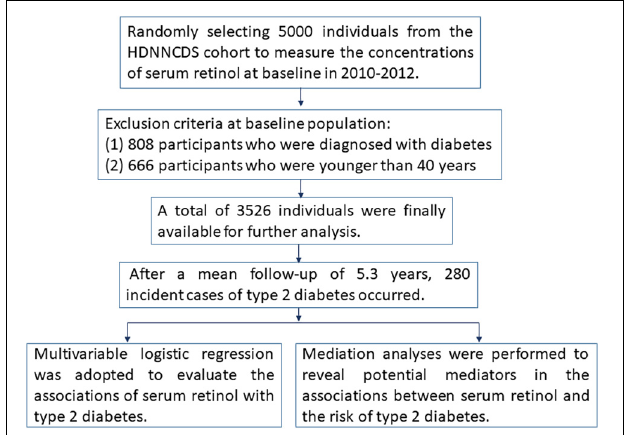
TABLE 1 | Baseline demographic and biochemical characteristics of participants in Harbin Cohort Study on Diet, Nutrition, and Chronic Non-communicable Diseases